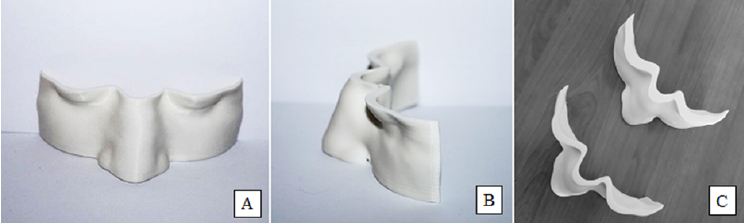
Figure 3. 3D-printed bolus: ( A ) frontal view; ( B ) lateral view; ( C ) boluses with different thicknesses (0.5 cm and 1.0